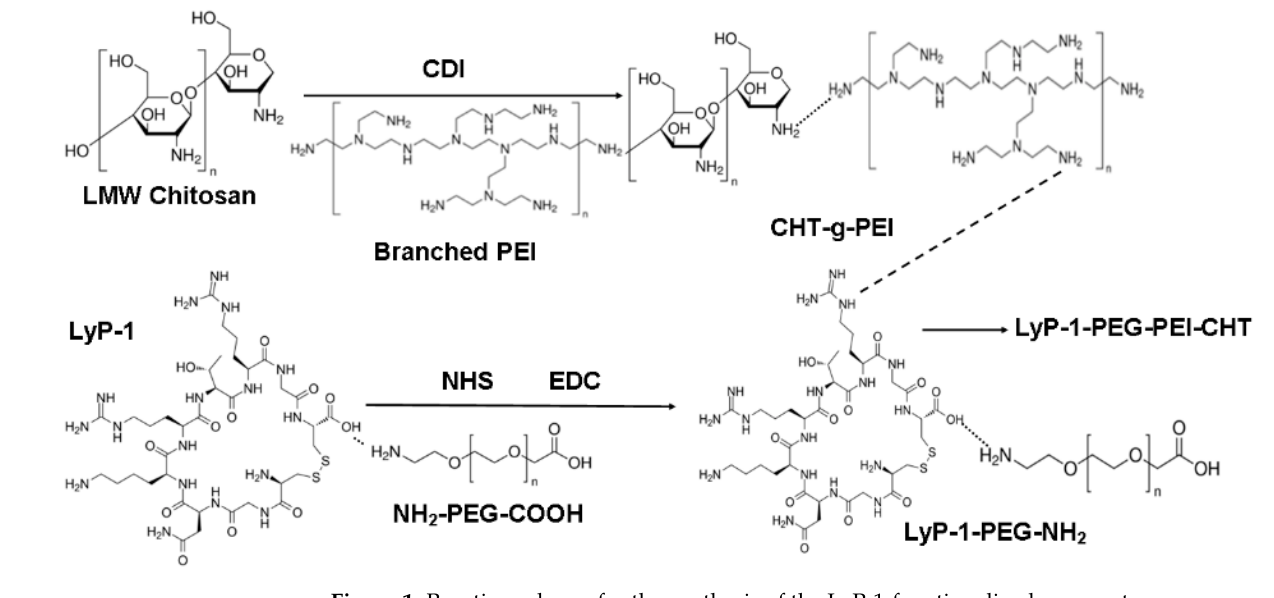
Figure 1. Reaction scheme for the synthesis of the LyP-1-functionalized nanosystem. FTIR spectra and detailed absorption peaks of the polymers and conjugates are presented in Figure 2B (1); characteristic peaks of CHT, due to the C-O bend of the pyranose ring, was assigned at 886.69 cm − 1 (Figure 2B (1(i))), while the signals at 854.83 cm − 1 and 1465.07 cm − 1 were assigned to the –NHCH 2 CH 2 stretch in PEI (Figure 2B (1(ii))). Similarly, the peak at 841.33 cm − 1 (from the -CH 2 CH 2 O-]n) represented the presence of PEG (Figure 2B (1(iii))). Absorption peaks at 3038 cm − 1 and 3376 cm − 1 indicated C-H and N-H stretching of the imidazole between the chitosan and PEI NH 2 groups in the grafted conjugate (Figure 2B (2(iv))) [7]. Reduction in the frequencies of the characteristic peaks of both CHT at 882.85 cm − 1 and PEI at 828.80 cm − 1 confirmed the successful grafting of the two polymers. Of interest are the formations of the amide bonds in the LyP-1-PEG-NH2 conjugate. As seen in Figure 2B (3(v–vi)), the peak at 1697.46 cm − 1 represented the C=O stretch absorption N-H bond I, 1463.54 and 1495.23 cm − 1 were attributed to N-H bend and C-N stretch absorption in N-H bond II, while the triple peaks (1310.28, 1282.89 and 1261.99 cm − 1 ) were assigned to the planar N-H bend and C-N stretch in N-H bond III. A peak at 3395.04 cm − 1 indicated the N-H stretch from the NH 2 bound to the PEG. Upon the conjugation of the LyP-1-functionlaized amino terminal PEG onto CHT-g-PEI, there seemed to be a small increase in the overall amine density. The absorption peaks of the free terminal amine shifted to a higher frequency of 3408.00 cm − 1 from 3395.04 cm − 1 . Similarly, the frequencies of the amide bonds shifted slightly to 1697.54 cm − 1 (amide I), 1463.55 cm − 1 and 1496.61 cm − 1 (amide II); and 1310.56, 1280.18 and 1253.22 cm − 1 in amide III (Figure 2B